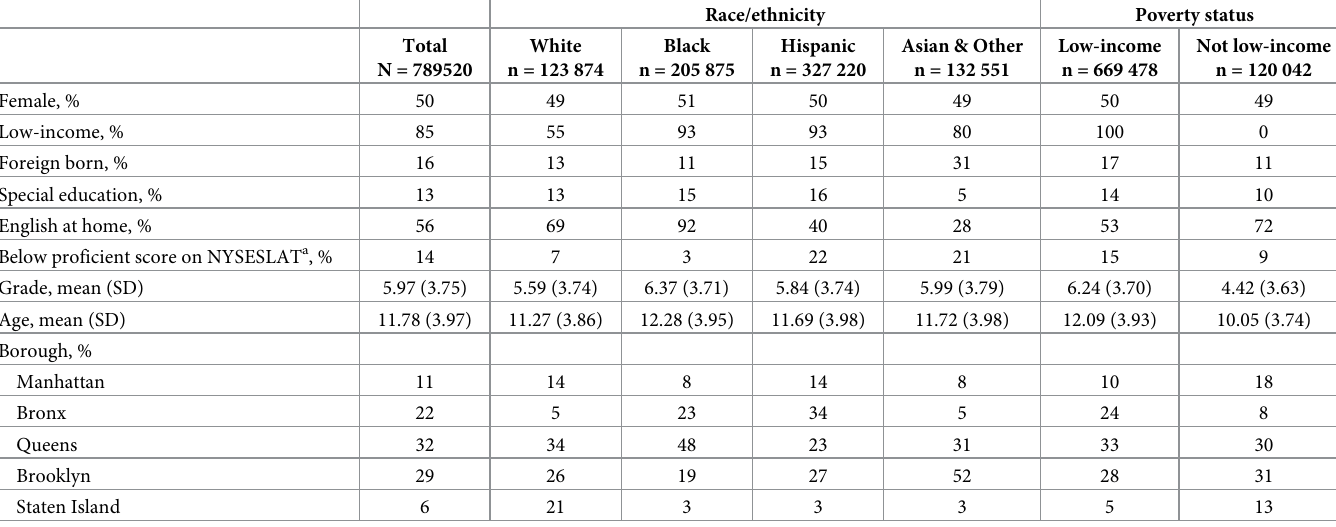
Table 1. Students’ socio-demographic characteristics,